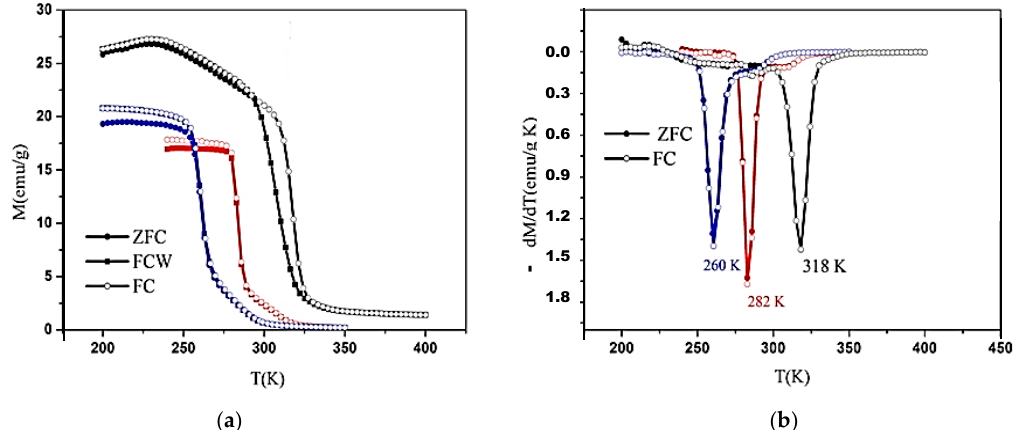
Figure 6. ( a ) Temperature dependence of magnetization for 3 selected compounds. Zero-field-cooled and field-cooled (µ 0 H=0.05T) indicate the possible hysteresis effect at the magnetic transition region; ( b ) derivatives of thermomagnetic curves that enables us to accurately determine the transition temperature—black: Mn 0.7 Fe 1.3 P 0.65 Si 0.35 ; red: Mn 1.3 Fe 0.7 P 0.35 Si 0.65 ; blue: Mn 1.4 Fe 0.6 P 0.30 Si 0.70 .